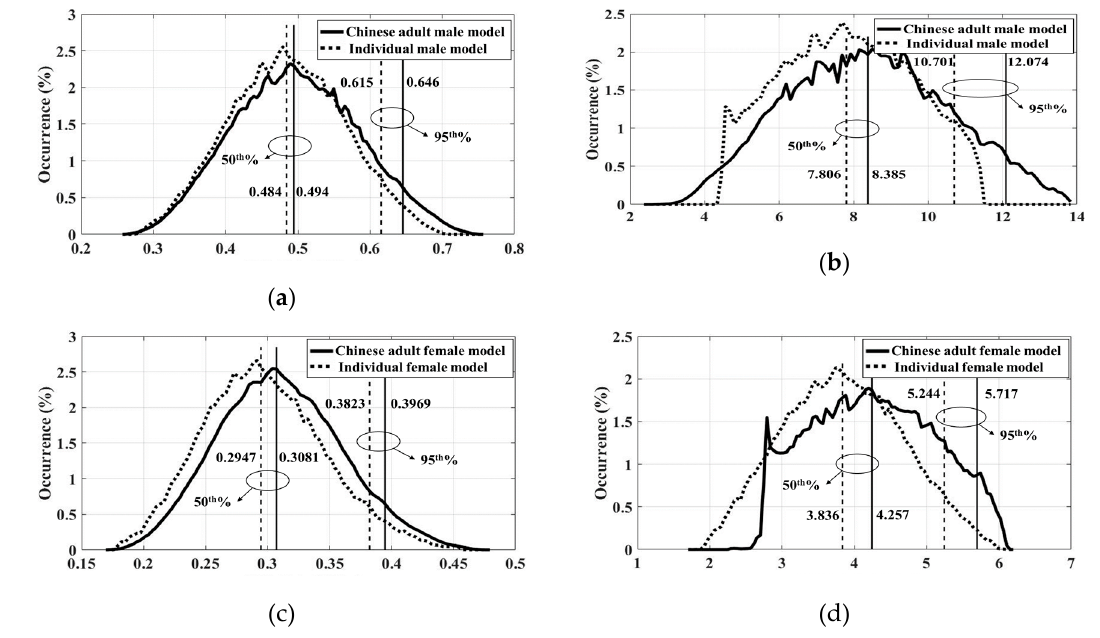
Figure 7. SAR occurrence calculated by surrogate model: ( a ) wbSAR for the male models; ( b ) pSAR10g for the male models; ( c ) wbSAR for the female models; and ( d ) pSAR10g for the female models. The results indicated that the individual models yielded similar SAR results even for various percentiles. For example, at the 50 th percentile, the deviation for wbSAR from the male models is 2.07% and 4.54% for the female models. At the 95 th percentile, the deviation is 5.04 % for the male models and 3.82% for the female models. Deviation for pSAR10g ranged from 7% to 13% at the 50 th and 95 th percentile. 4. Discussion The models generated by the proposed modelling technique gave satisfactory accuracy of SAR estimation compared to the available fast individual modelling methods which demonstrated a deviation of 10–30% for pSAR10g [6,9]. The advantage of accurate SAR representation could be attributed to the anatomical details preserved by the proposed modelling technique. As known, the tissue distribution is essential to the local SAR. In total, more than 30 different tissues/organs were included in the individual model, which thus benefited for an accurate local SAR estimation. Another advantage of the proposed methodology is also obvious: The variables could be eventually traced to several anthropometry parameters (e.g., height and weight), which were dosimetrically important. This is a prospective method for individual modelling even without an optical or low-SAR MRI scan. The proposed modelling technique learned the inter-subject anatomical variation from the medical image dataset consisting of 79 healthy Chinese individuals (41 males and 38 females). The representation of the database could be enhanced by the inclusion of more subjects. To note, since the CT dataset was from the healthy subjects, the modelling method cannot be directly applied to the subjects with internal abnormalities, e.g., tumors. Another point that underpinned the modelling technique was the representation of the anatomical templates used for the registration of the low- contrast organs. The current templates were created mainly for demonstrative visualization so that the shapes of the organs were stylized with their profiles being significantly smoothed. Although we have achieved good SAR accuracy, the organ’s registration accuracy as well as the SAR results could be potentially improved by choosing the confirmed anatomically correct templates. To note, including the individual information from other anatomical datasets, even for partial body, can help